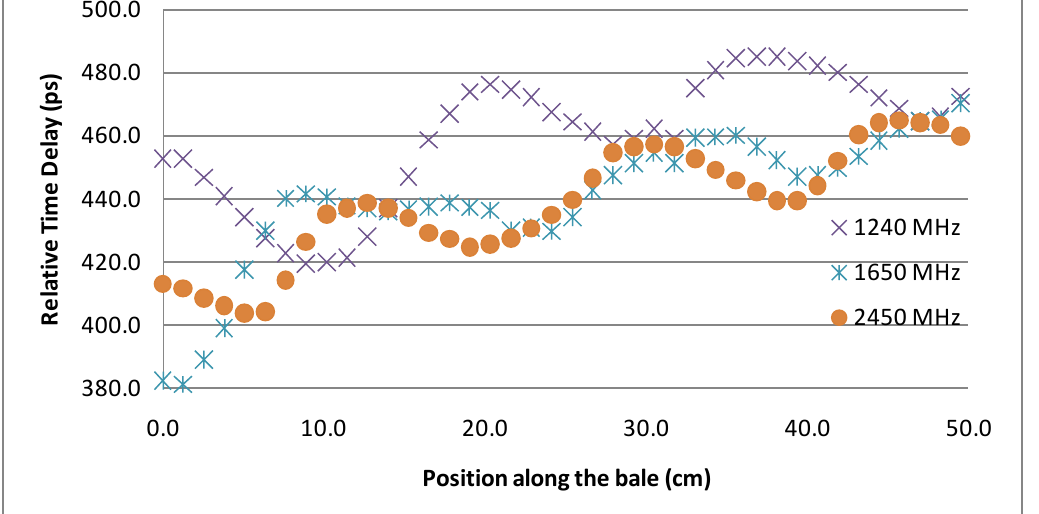
Figure 6. Response of an imaging antenna pair under the influence by metal bale ties, showing the metal bale-tie created varying phase delay response, as the bale is conveyed past the sensor along the x axis in the figure below. Of interest is the distances between the peaks in the phase delay shown are nearly the same distance as the metallic wire-tire spacing’s on the bale. Also of note is that the tested bale was configured with uniform moisture content with a slow linear-taper in density, thus the correct response would be a linear line with a positive slope (4:5) from right to left, free from oscillations.